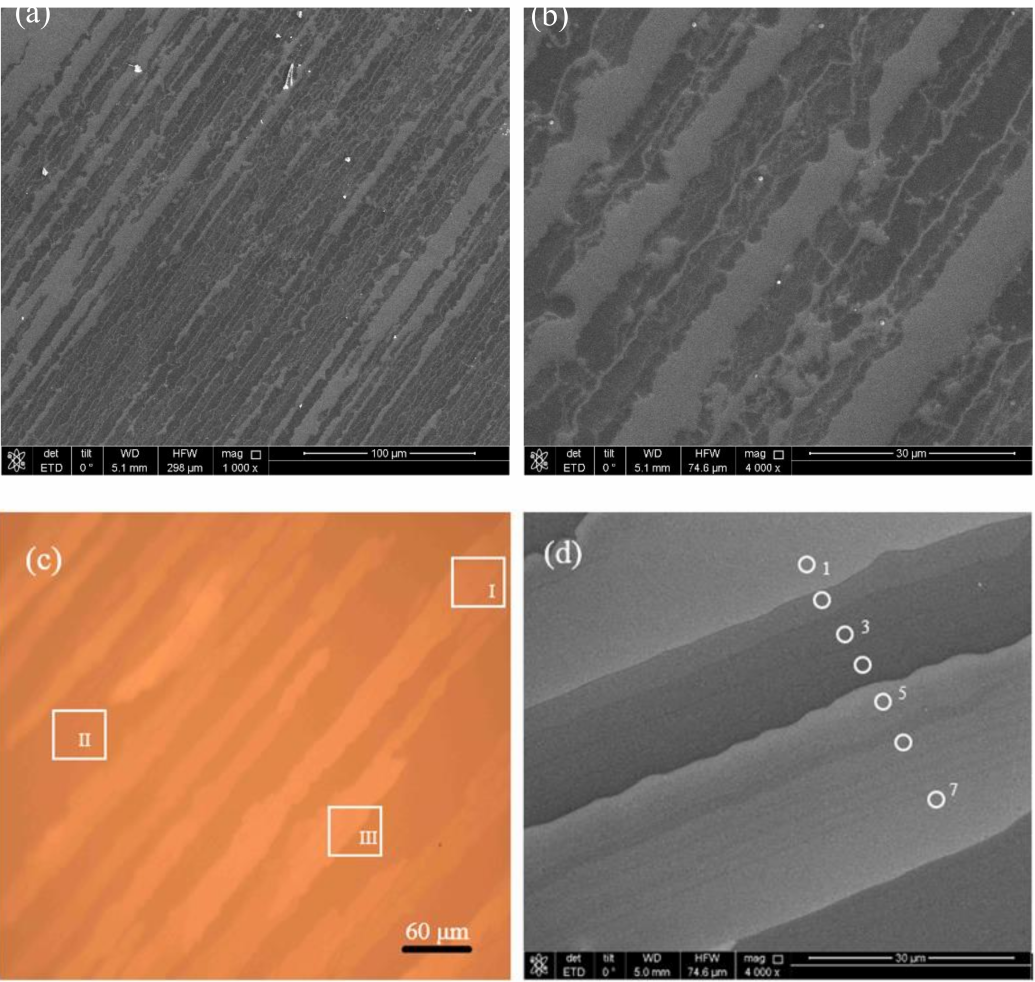
Figure 3. Surface morphology of Wafer C: ( a , b ) SEM images of surface of Wafer C1; ( c ) optical image and ( d ) SEM image of Wafer